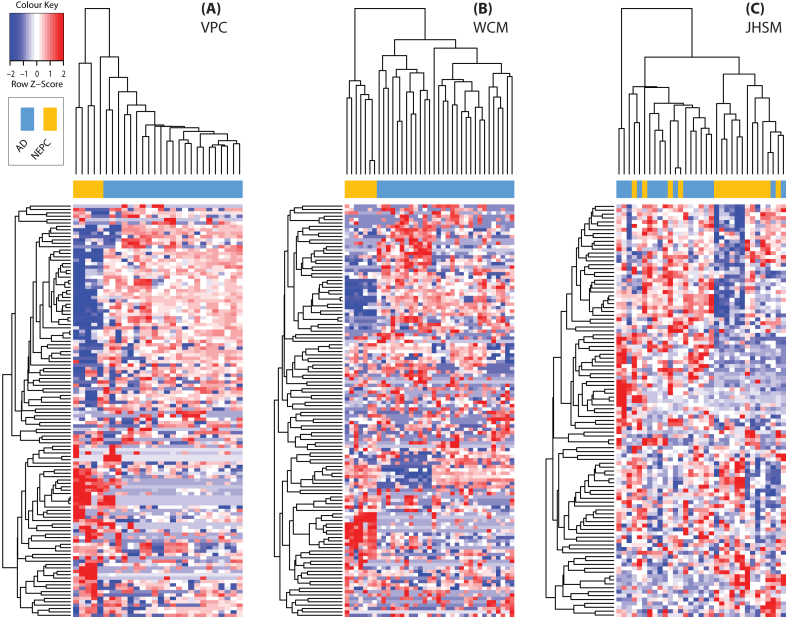
NEPC lncRNA expression signature and clinical classifier. Unsupervised hierarchical clustering of the 122 identified lncRNAs from (A) VPC and (B) WCM cohorts. Validation of this signature was shown in the (C) JHSM cohort. Samples (columns) are labelled as adenocarcinomas (blue) or neuroendocrine (yellow) tumours. See Supplementary Fig. S3 for row/lncRNA labels for each plot.